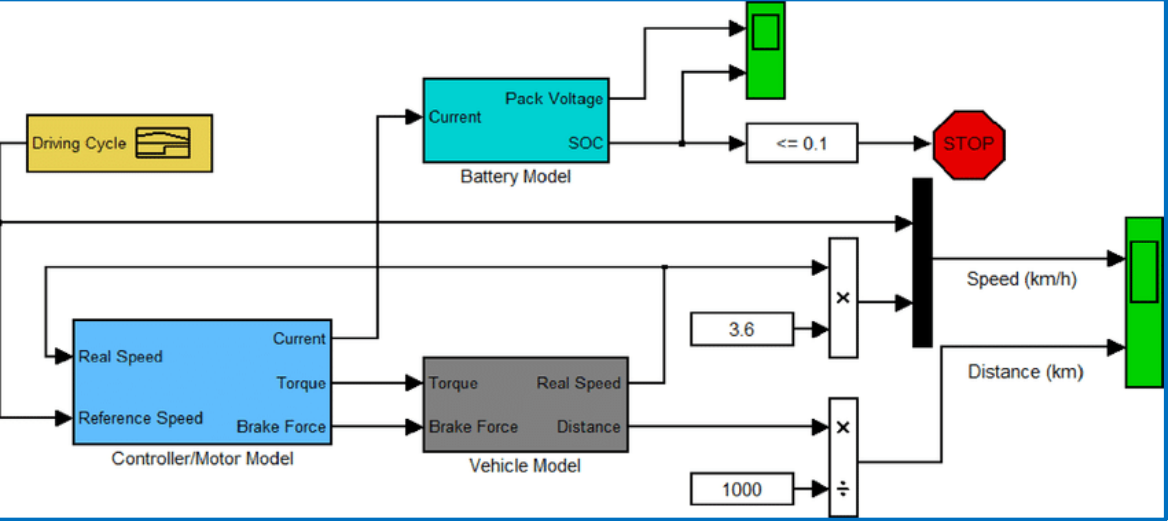
Figure 5. Simulation of an electric vehicle.